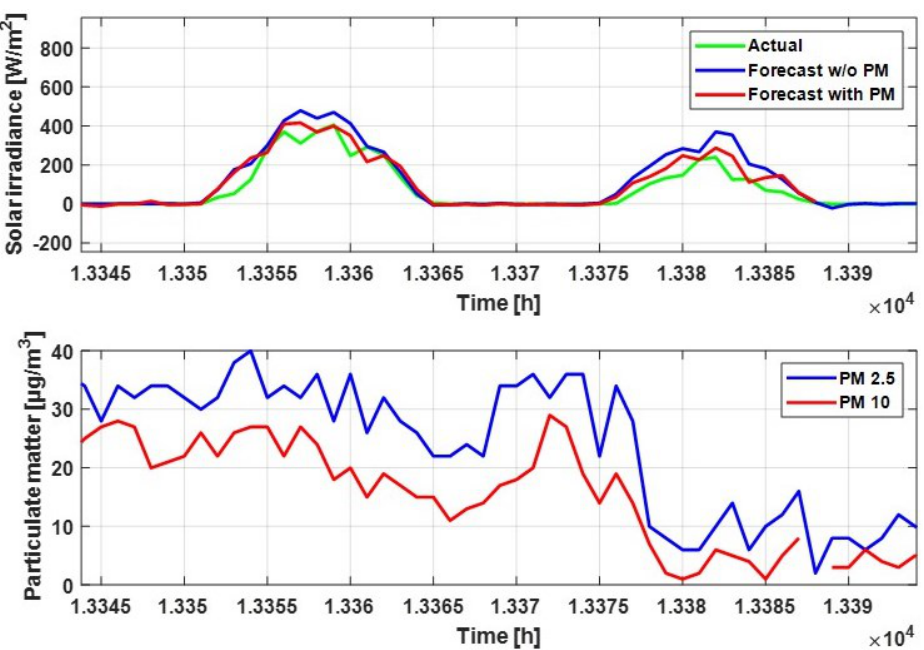
Figure 9. Comparison between the result of solar irradiation forecast with and without (w/o) considering particulate matter